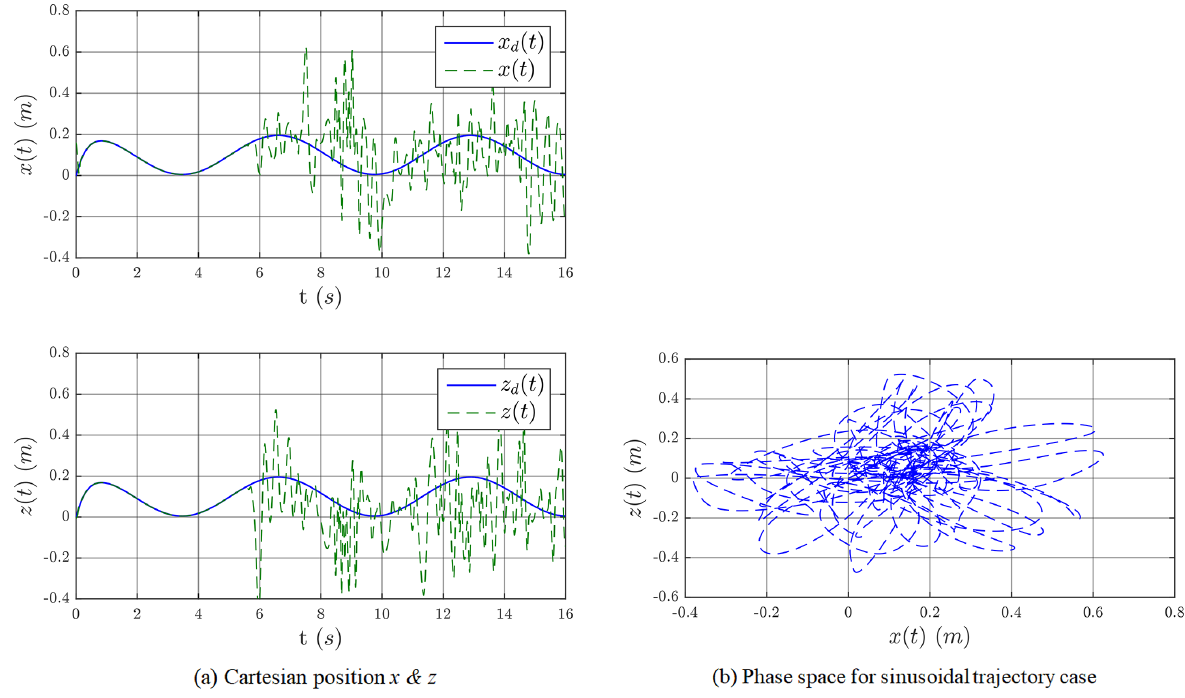
Figure 5. The Cartesian controller without adaptive chaos scheme for the sinusoidal trajectory case.